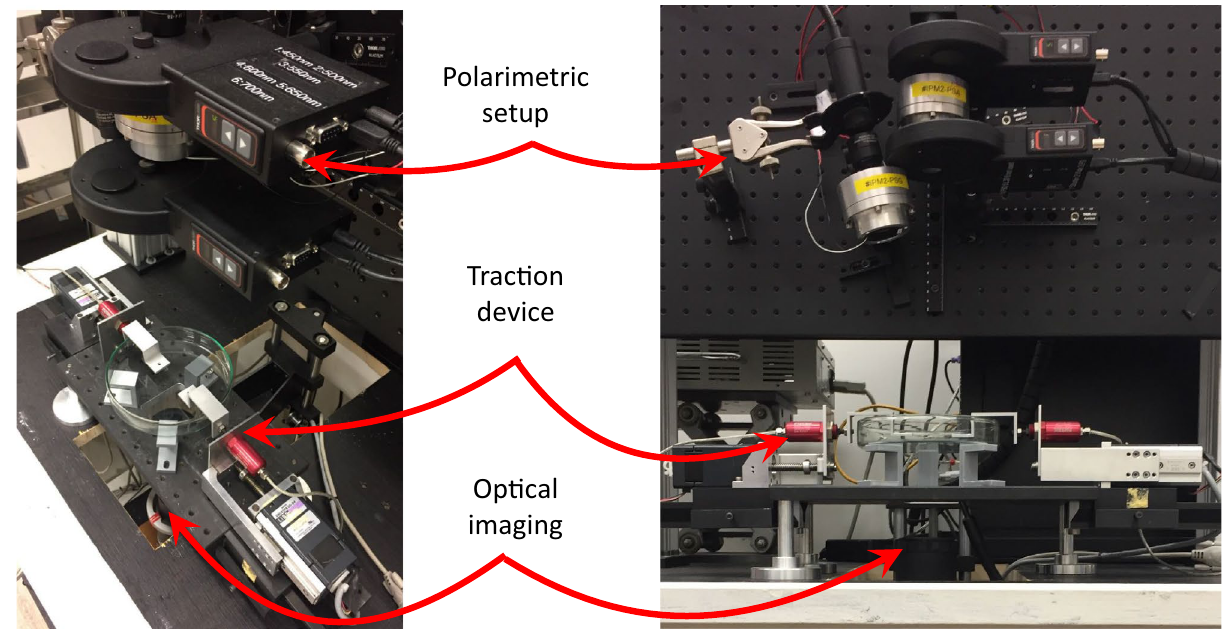
Figure 8. Global and close views of our experimental